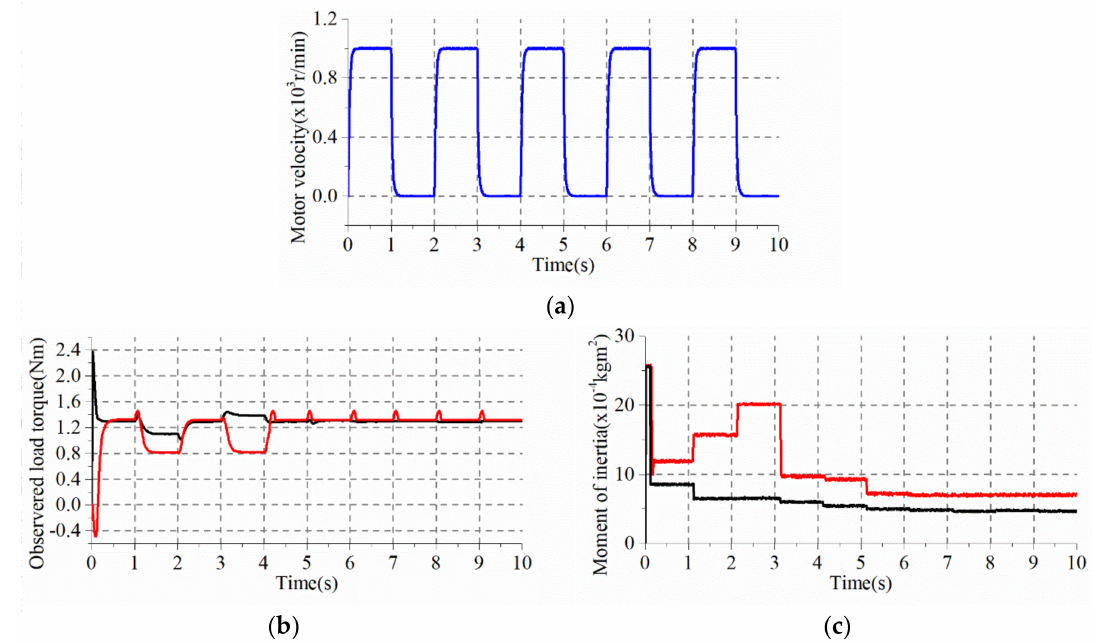
Figure 7. Comparison of two algorithms with initial value ˆ J ( 0 ) = 5 J and 1.2 Nm load torque, 0–1000 rpm repeated step speed command. ( a ) Speed response (blue); ( b ) Observed load torque ˆ T L (black line denotes AKO-RLS result, red line denotes KO-RLS result); ( c ) identified inertia line denotes AKO-RLS result, red line denotes KO-RLS result).